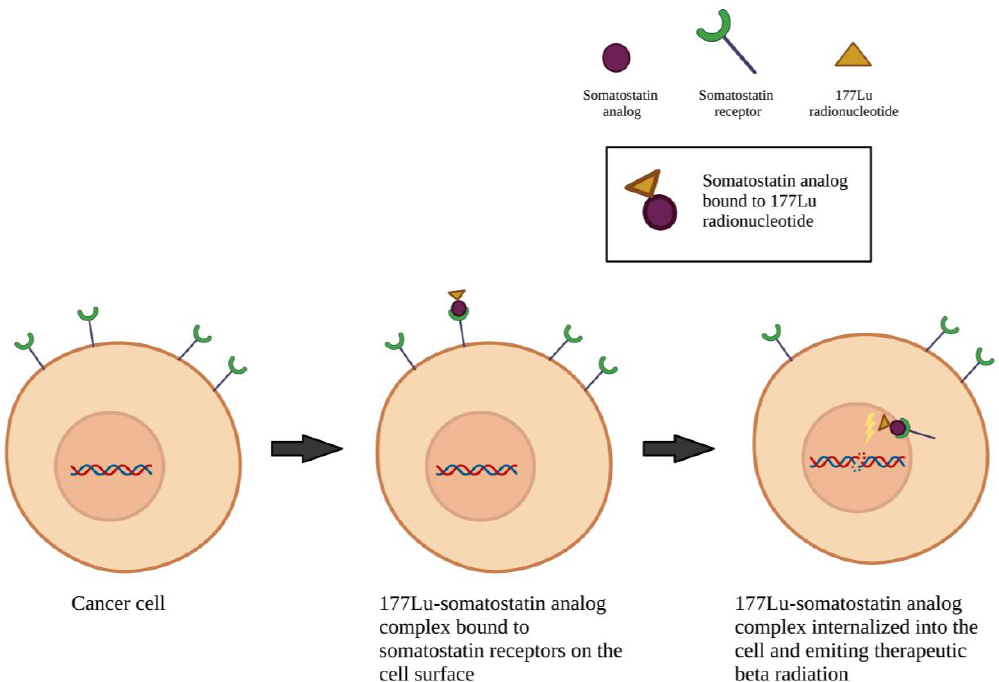
Figure 4. Mechanism of action of targeted radiolabeled somatostatin analogs. Made on bioren- der.com.